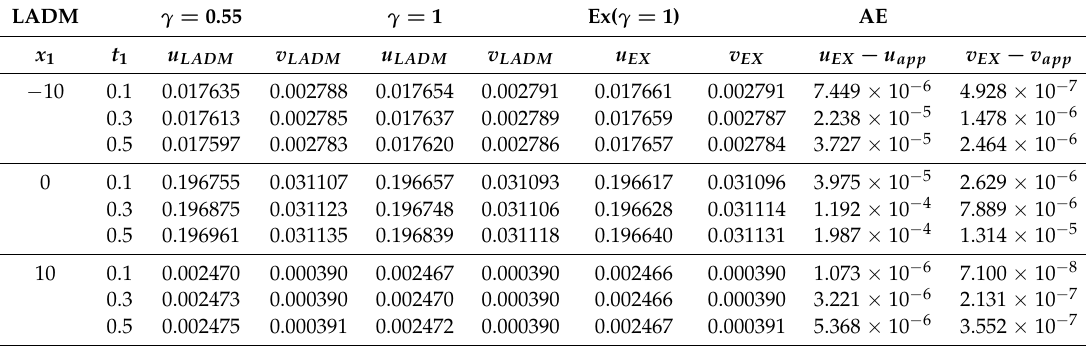
Table 1. Solution of LADM for different values of γ when η = 0.001 and Absolute Error (AE) of Example